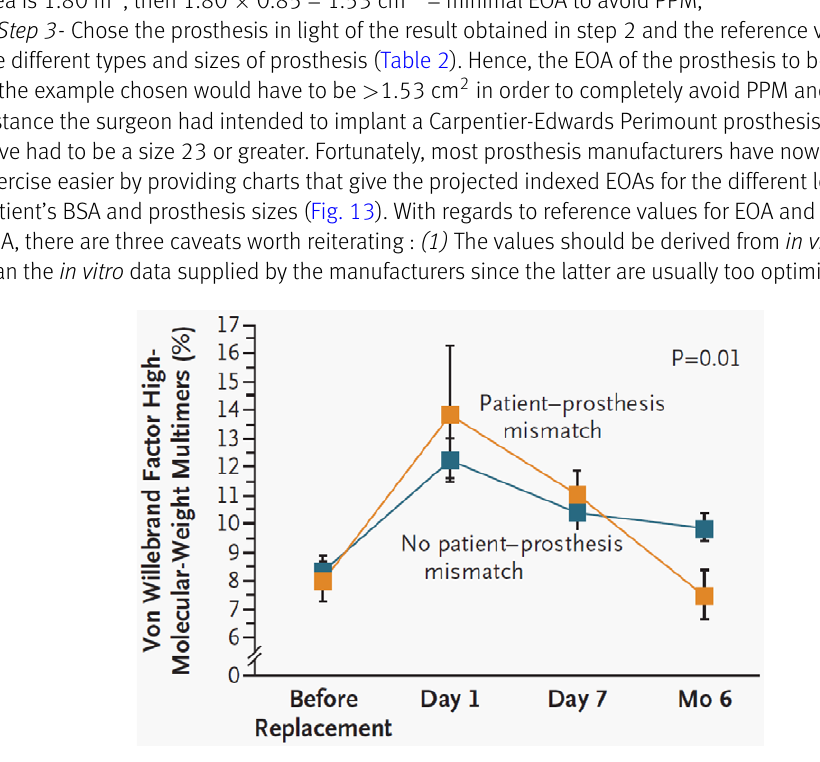
Figure.11 Evolutionofhighest-molecular-weightvonWillebrandfactormultimersafteraorticvalvereplacement in patients with and without prosthesis-patient mismatch (PPM). (Reproduced and modified with permission from [81]).